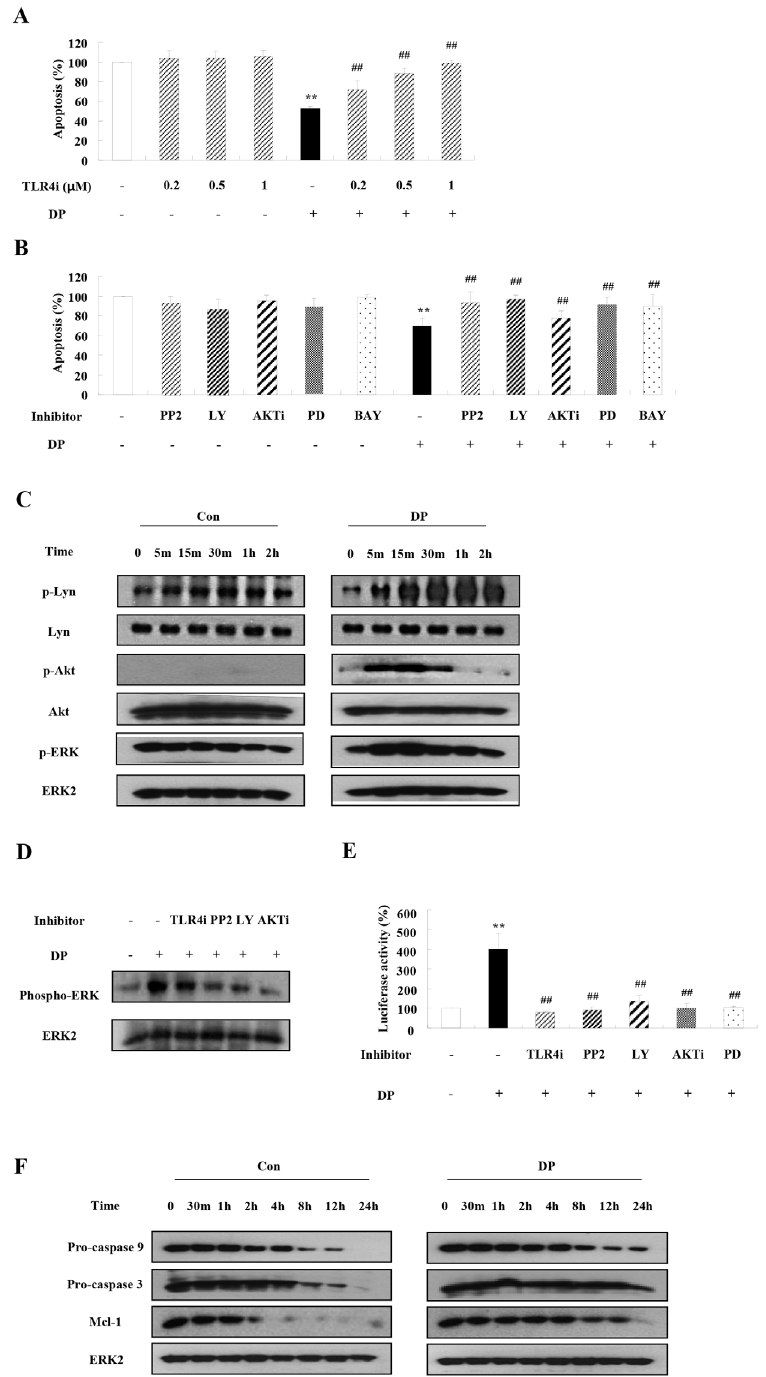
Fig 2. DP induces the inhibition of neutrophil apoptosis via activation of TLR4, Lyn, PI3K, Akt, ERK and NF- κ B, and suppression of the caspase9/3 pathway. (A-B) Normal neutrophils (3 < n < 7) were pre- treated for 1 h with and without TLR4i in the indicated concentration (A) or 10 μ M PP2, 10 μ M Ly294002 (LY), 10 μ M AKTi, 10 μ M PD98059 (PD) and 10 μ M BAY-11-7085 (BAY) (B), after which the cells were incubated for 24 h in the absence and presence of DP (10 μ g/ml). Apoptosis was analyzed by measuring the binding of annexin V-FITC and PI. Data are presented relative to the control, which was set at 100% of the means ± SD. ** p < 0.01 indicates a significant difference between the control and DP-treated groups, and ## p < 0.01 represents a significant difference between the DP-treated group and the inhibitor-treated group. (C)